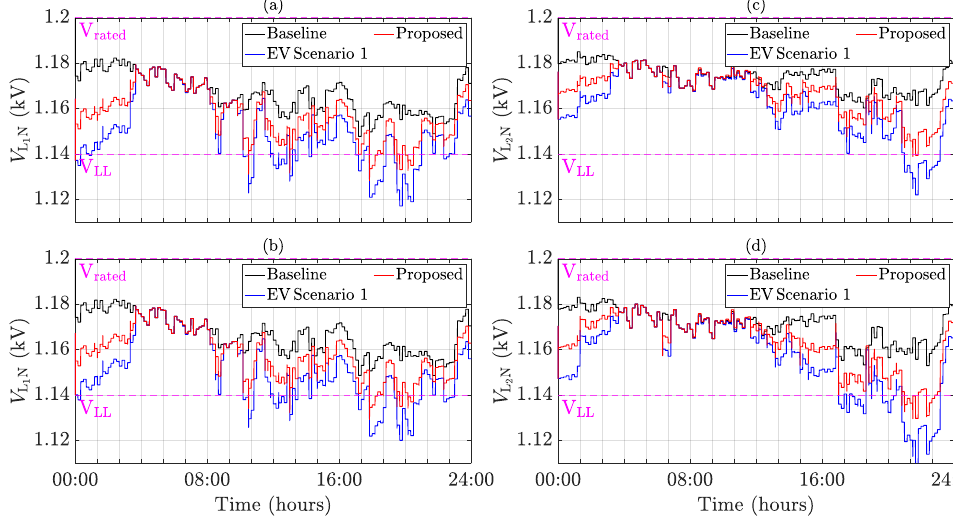
N ; ( b ) at − N ; ( d ) at bus 13 −